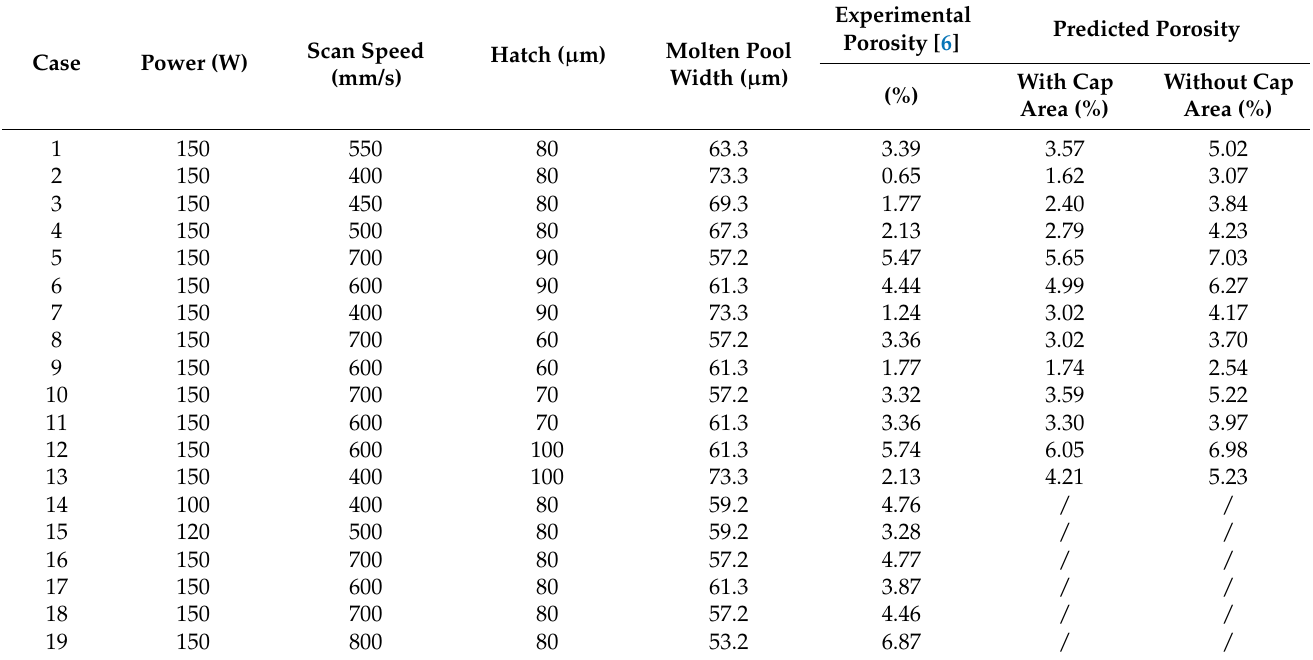
Table 1. Predictions and experimental data of lack-of-fusion porosity under various process